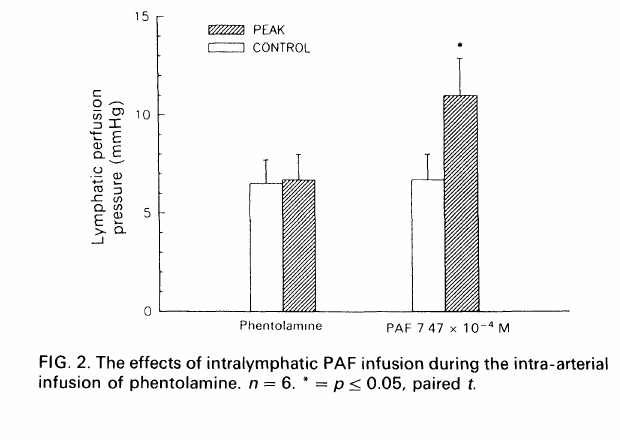
Table 2. Effect of intralymphatic PAF infusion during the intra- arterial infusion of phentolamine on vascular pressures Phentolamine